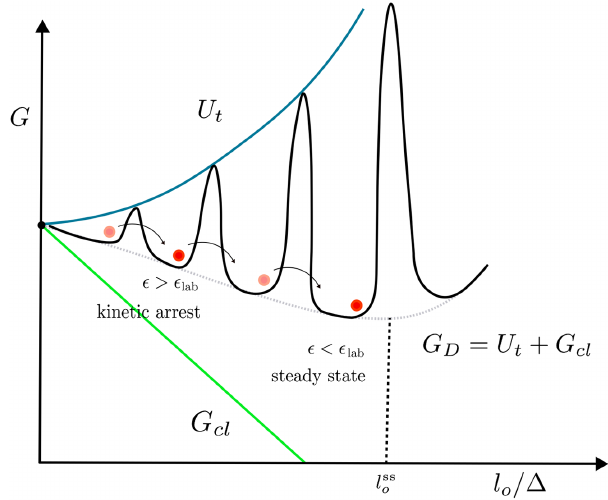
FIG. 4. The free-energy landscape that results from cross-linker binding in a force dipole. The total free energy G is a summation D of cross-link ( G ) and tether ( U ) contributions. G is a linear t cl cl function of overlap, and the slope of this line can be thought of as the average free-energy difference per addition of a single binding ∝ l = Δ ). site in the dipole (since the number of binding sites n p o The dipole ’ s time scale of approach to steady-state overlap = Δ diagram) is in (dipole overlap shown as red dots in G − l o general an exponential function of cross-link binding affinity such that a dipole can become kinetically arrested on the ≪ τ laboratory time scale if ϵ > ϵ , and thus τ . Otherwise, lab lab ss the dipole can reach the steady-state free-energy minimum overlap l ss o